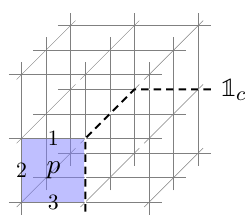
Figure 10. A 1 c -string in the 3d toric code